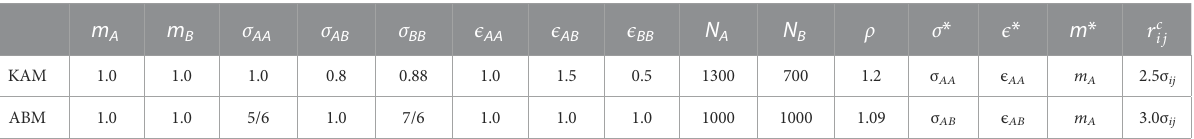
TABLE 1 Summary of model